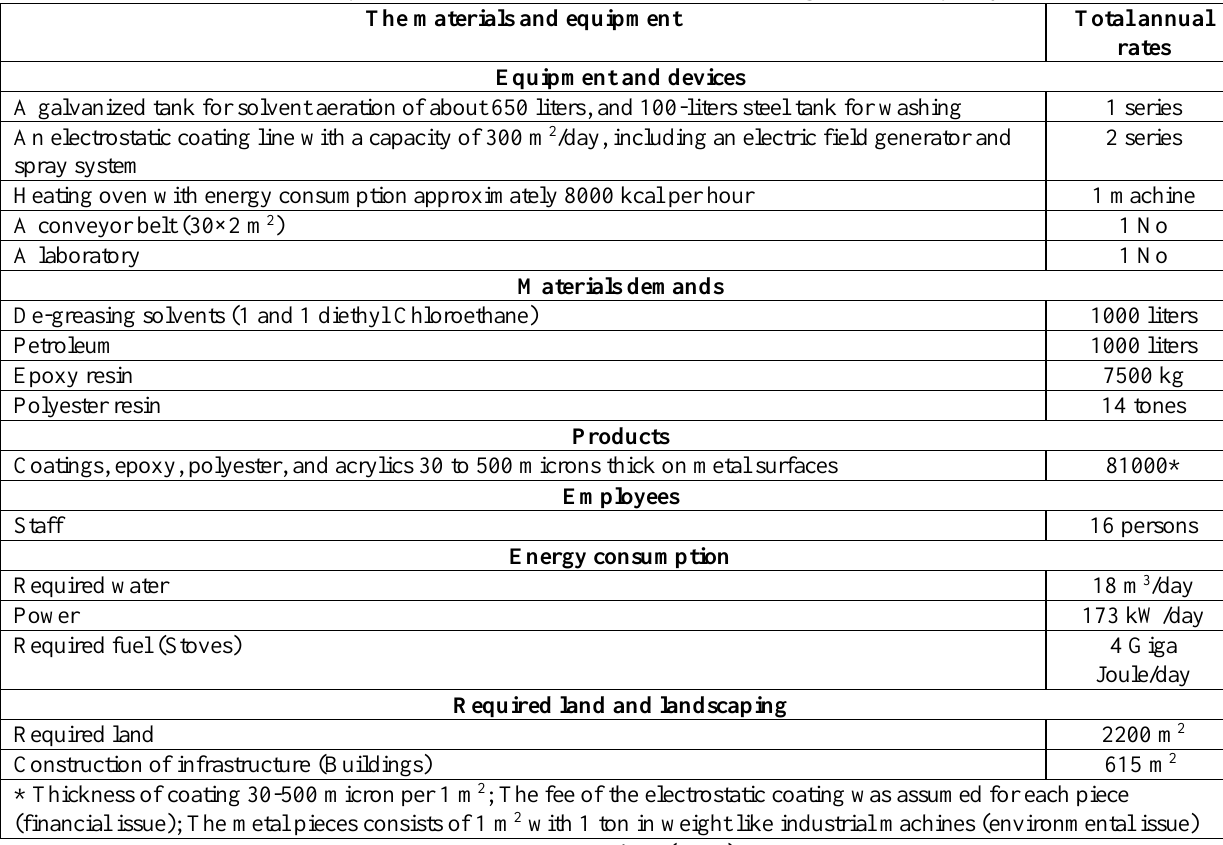
Table 1: The annual requirements of industries of electrostatic coating (nominal capacity of 81000*).